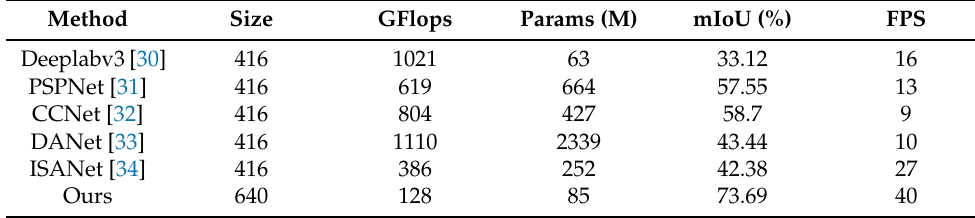
Table 12. Comparison with the results of other segmentation